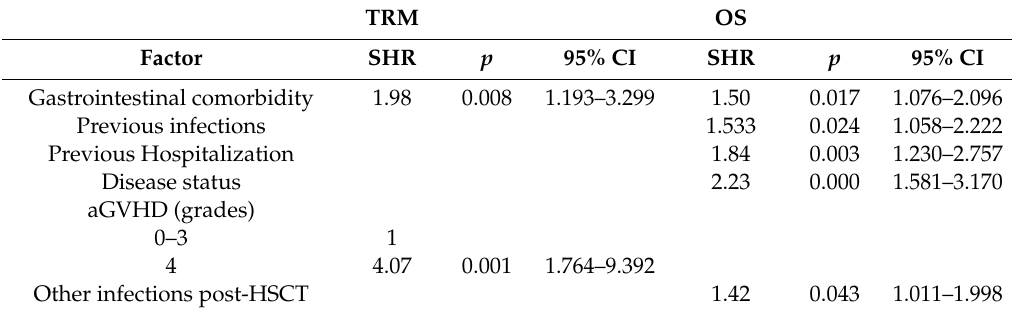
Table 6. Multivariate analysis of risk factors for TRM and